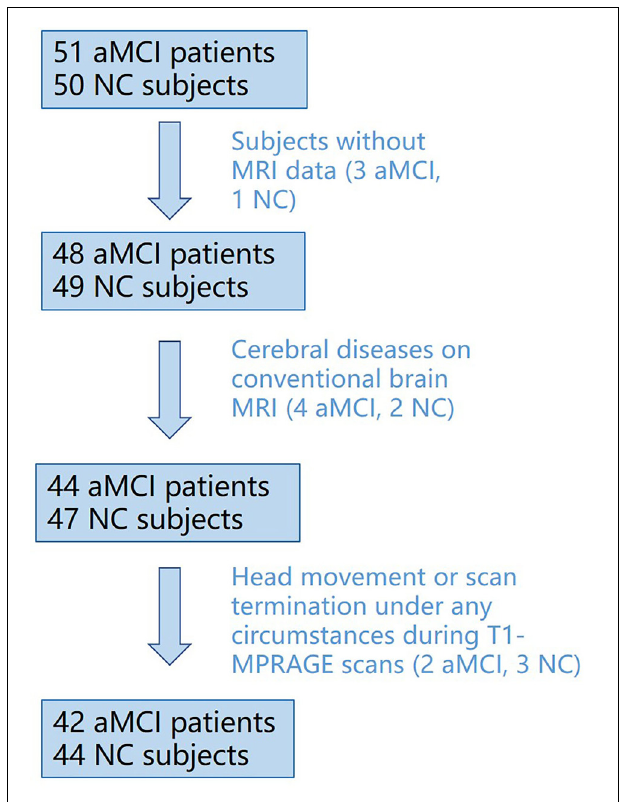
FIGURE 1 | Flowchart of inclusion/exclusion process for subject